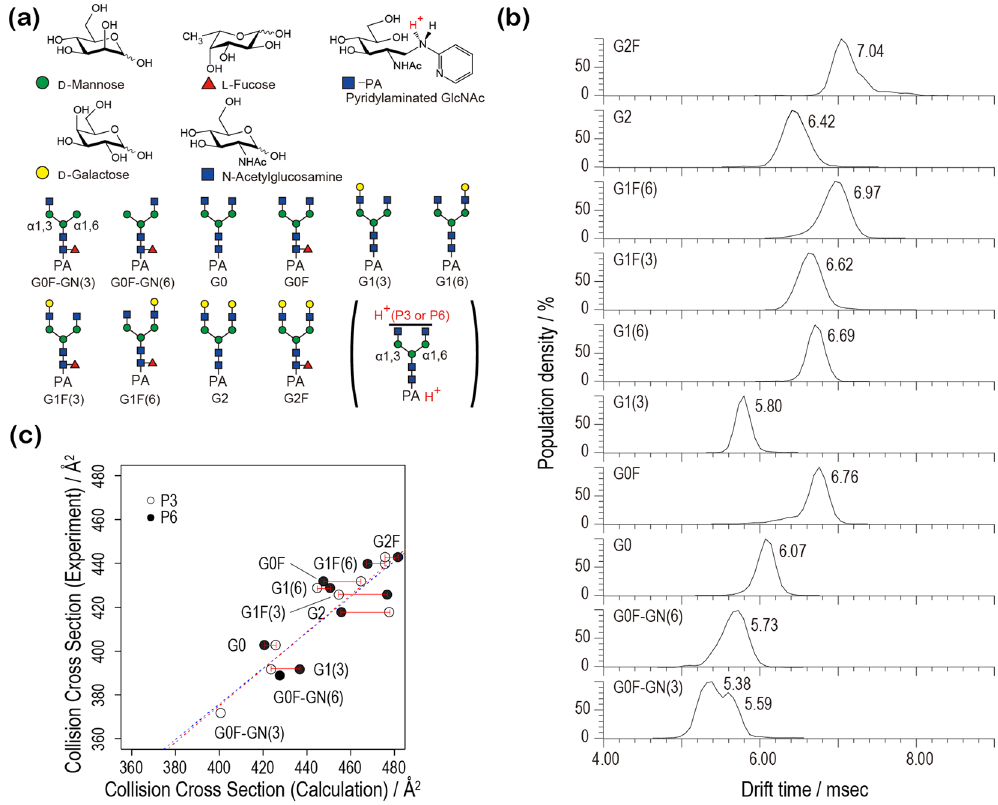
Figure 1. ( a ) Symbolic representation of the ten PA-glycans studied. ( b ) Experimentally observed arrival time distributions of the ten PA-glycans 23 . ( c ) Plot of calculated Collision Cross Sections (CCSs) in N 2 gas against experimental values obtained in N 2 gas. P3 and P6 indicate the different protonation states (P3: H + at α 1-3 (white) and P6: H + at α 1-6 branch (black)) (Dotted lines: regression lines with the correlation coefficient of 0.90 (P3, blue) and 0.89 (P6, red),